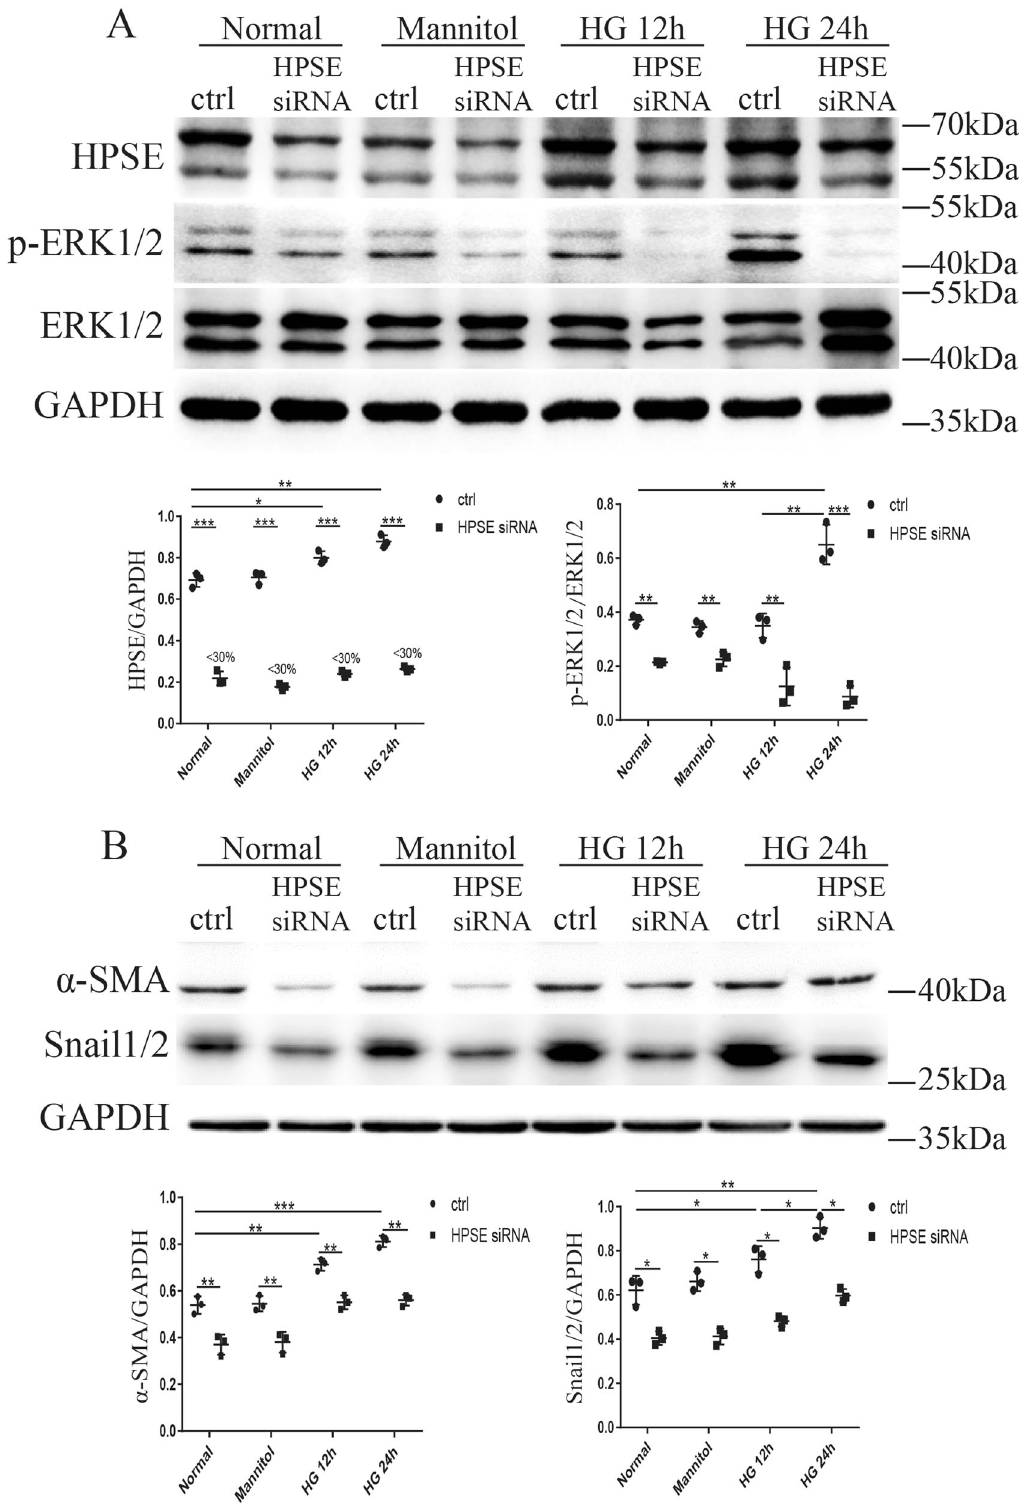
Fig. 5 HPSE siRNA inhibited EndMT in cultured GEnCs through inhibiting p-ERK1/2. A HPSE siRNA silencing decreased the expression of HPSE by 70%. Compared with normal glucose, high glucose-increased the expressions of p-ERK1/2 ( A ) and mesenchymal markers including α - SMA and Snail1/2 ( B ), both of which were signi fi cantly alleviated by HPSE siRNA. Each vertical bar represents the mean ± SD ( n = 3) analyzed by one-way analysis of variance (ANOVA) followed by Tukey ’ s multiple comparisons test. * P < 0.05, ** P < 0.01, and *** P < 0.001.